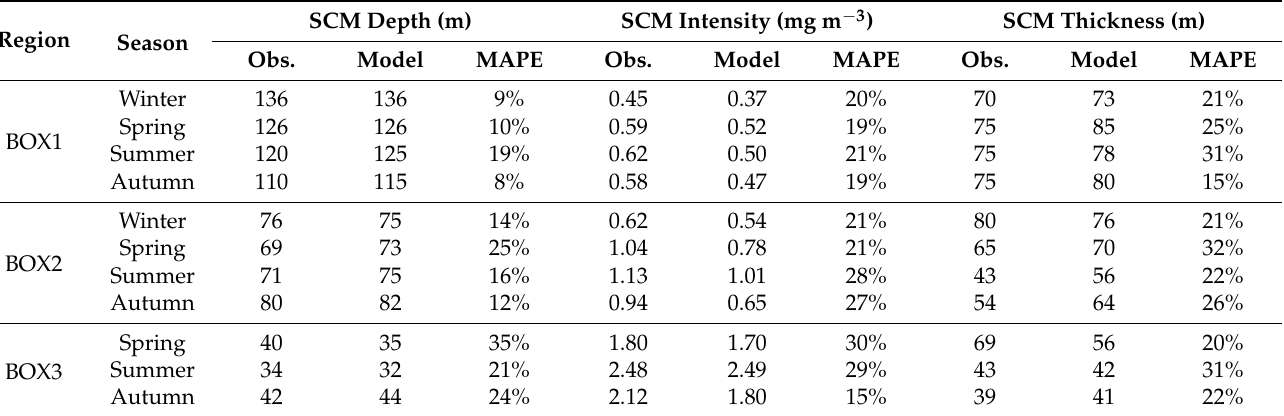
Table 4. Comparison of seasonal averaged SCM characteristics of three BOXes from test set with observations. Winter is defined as from December to February, and so